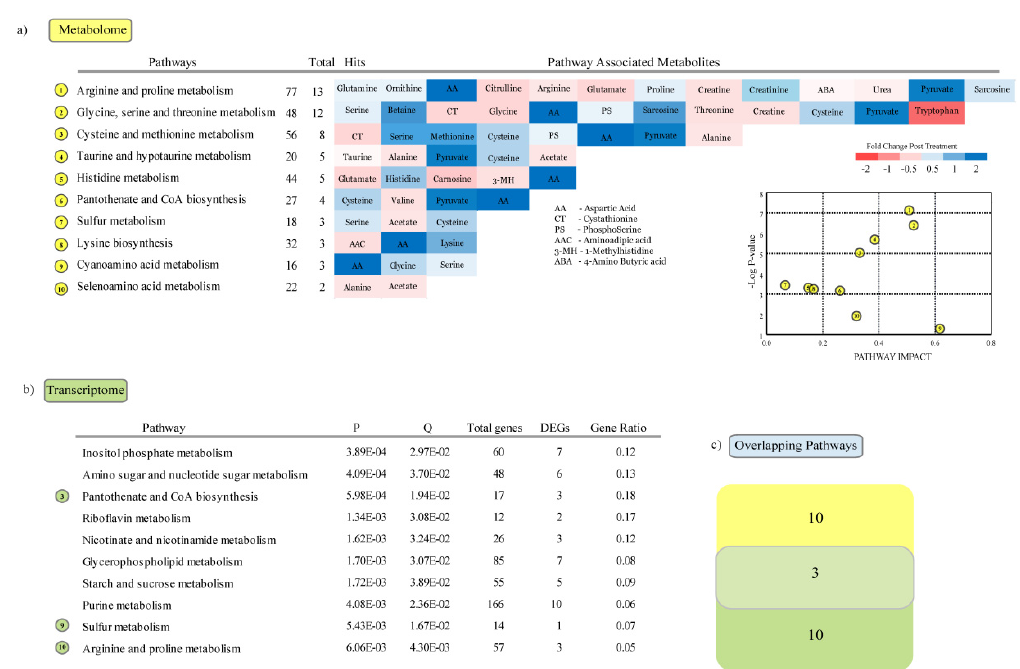
Figure 7. Metabolic pathways altered in the male group: ( a ) Metabolic pathway enrichment analyses of metabolites enriched in response to heat stress. ( b ) Metabolic pathway enrichment analyses of genes differentially expressed in response to heat stress. ( c ) Number of overlapping pathways enriched with DEGs and significantly differing metabolites in the heat stress group.